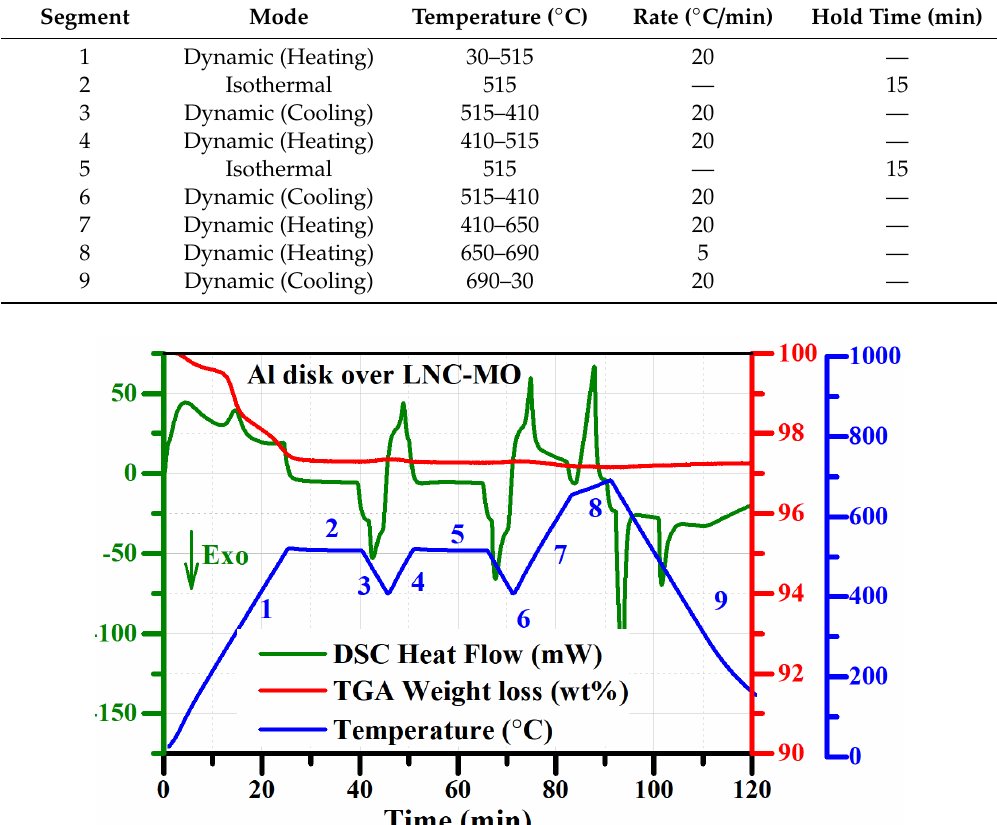
Figure 1. Recorded DSC heat flow and TGA weight loss profiles (numbers along the temperature profile are the segments listed in Table 2).